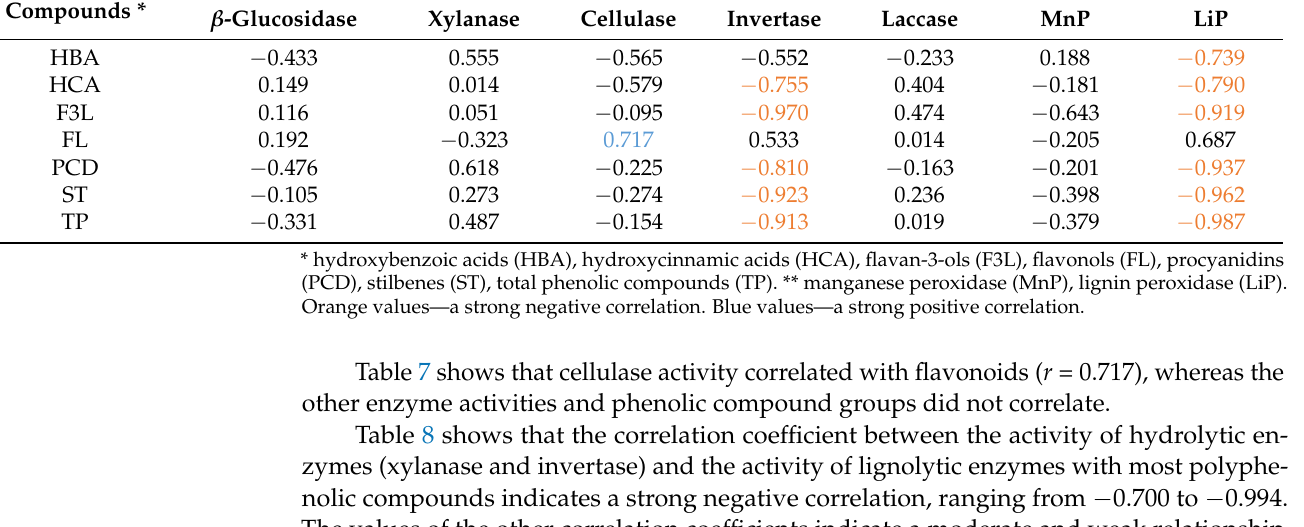
Table 7. Correlation coefficient ( r ) between the concentration of certain groups of phenolic compounds and the activity of hydrolytic and lignolytic enzymes in GP after SSF with R. oryzae in laboratory jars. Hidrolytic Enzymes Lignolytic Enzymes ** Phenolic Compounds * β -Glucosidase Xylanase Cellulase Invertase Laccase MnP